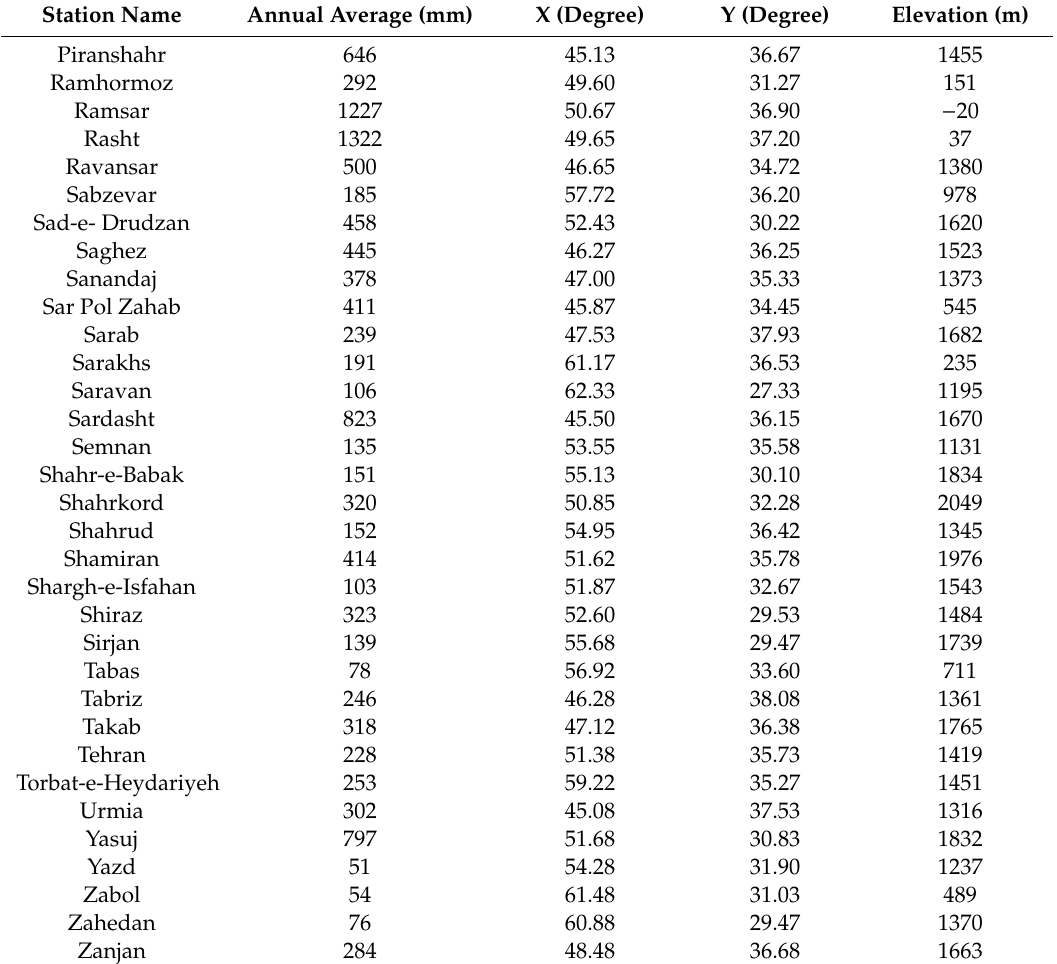
Table A2. Extended values for the annual average of precipitation in synoptic